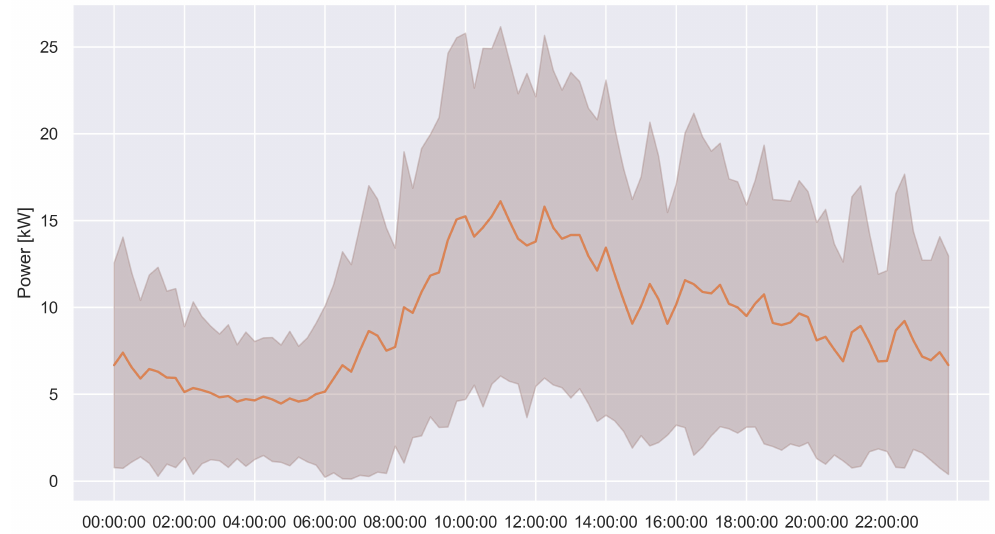
Figure 5. Average daily profile of the flexible load and its standard deviation.